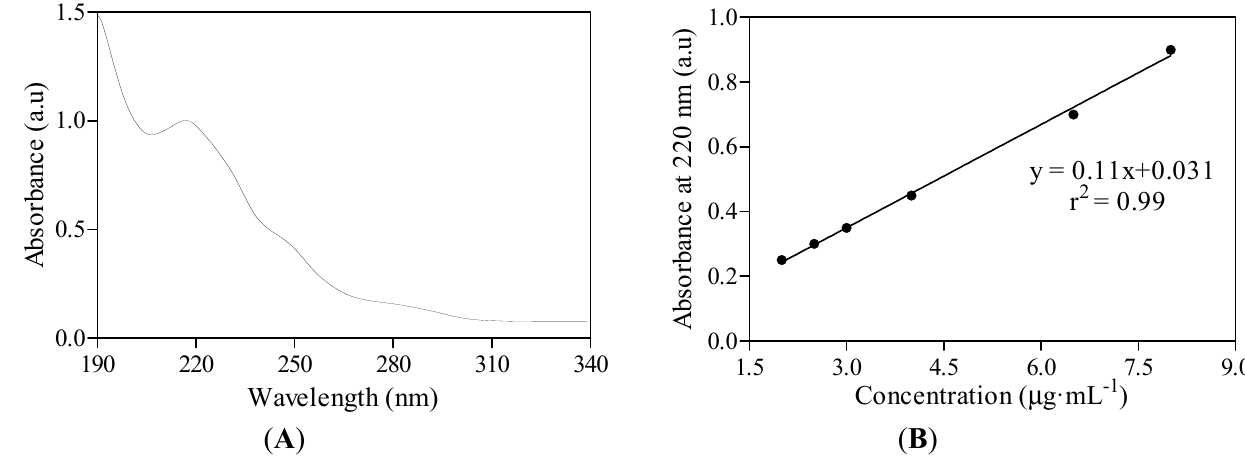
Figure 7. UV-Vis spectrum of midazolam as OR/CR mixture based on the absorbance peak found at wavelength 220 nm ( A ). Midazolam aqueous solution is examined in 50% of ethanol at a pH level of 3.0. The absorbance is measured in arbitrary units, which are abbreviated as a.u. The linear calibration curve was fitted to the experimental absorbance data ( B ).